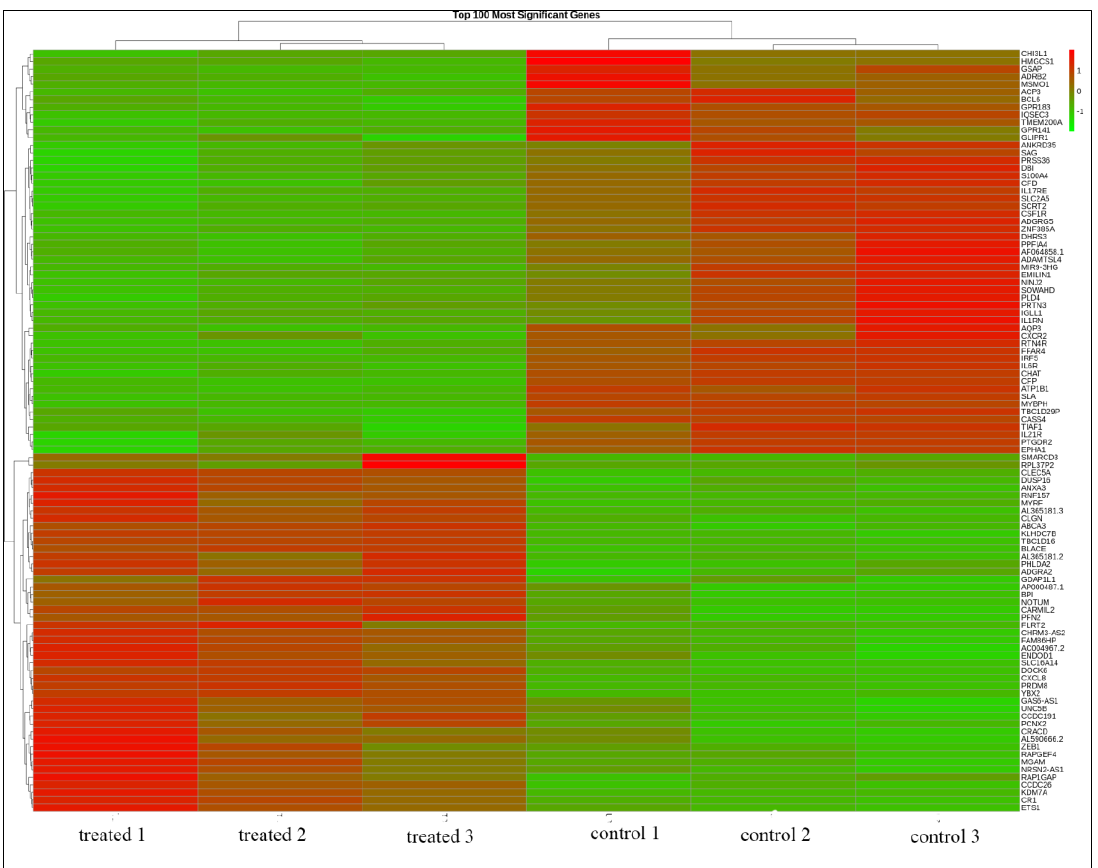
Figure 2. Heatmap of the top 100 significant DEGs in TQ − treated cell samples compared to control samples (p − adj < 0.01). The red color indicates upregulation, and the green color indicates downregulation. Each row represents one gene.